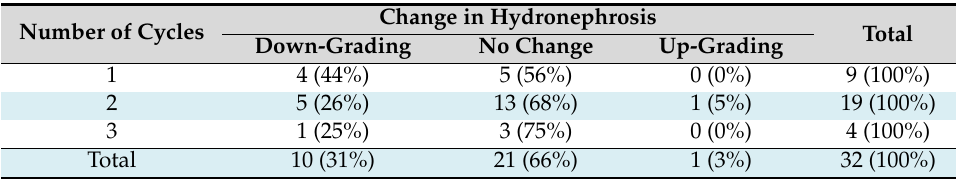
Table 3. Association between the number of neoadjuvant chemotherapy cycles and changes in hydronephrosis